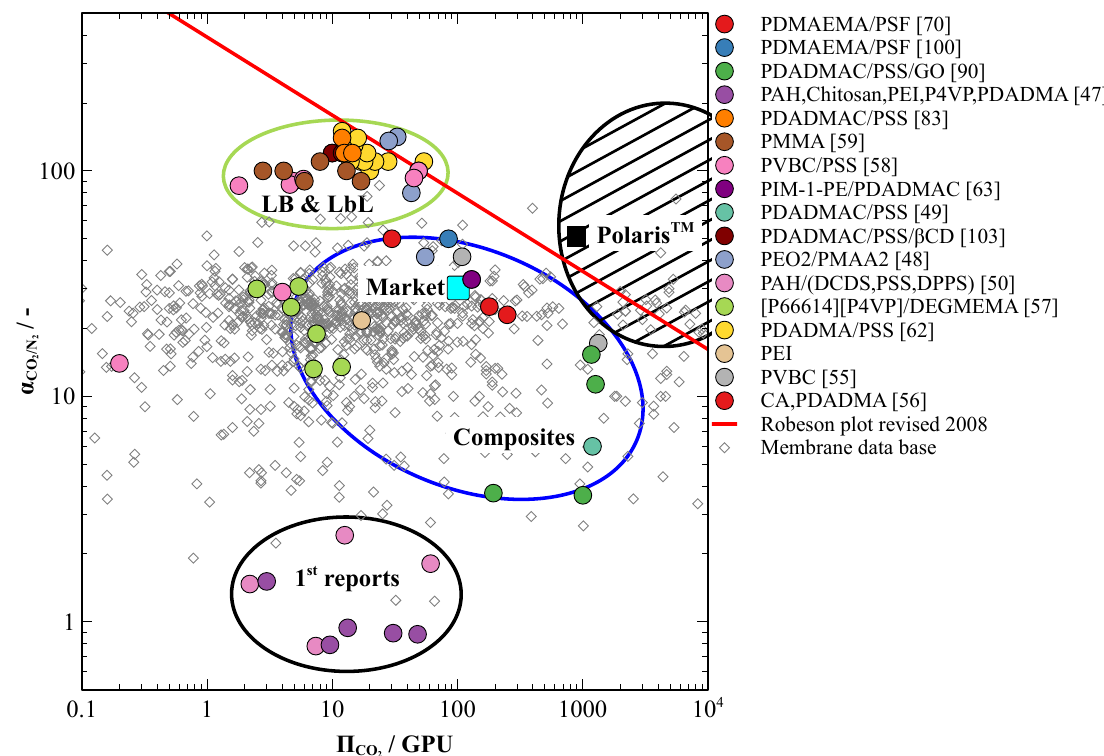
Figure 9. Comparison of PE-based membranes for CO 2 separation from flue gas on the R-M plot where the value indicated with the cyan square represents the market standard for CO 2 removal from natural gas and the value indicated with the black square represents the best performing membrane for CO 2 capture available on the market. The striped area suggests the desirable separation performance of CO 2 selective membranes for efficient capture from flue